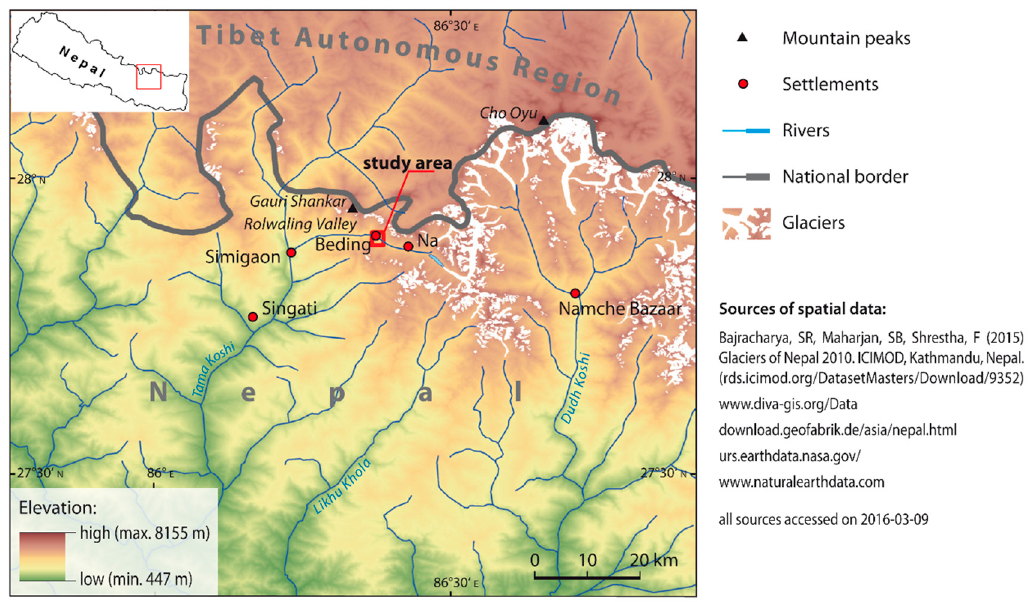
Figure 1. Location of the study area in east-central Nepal.